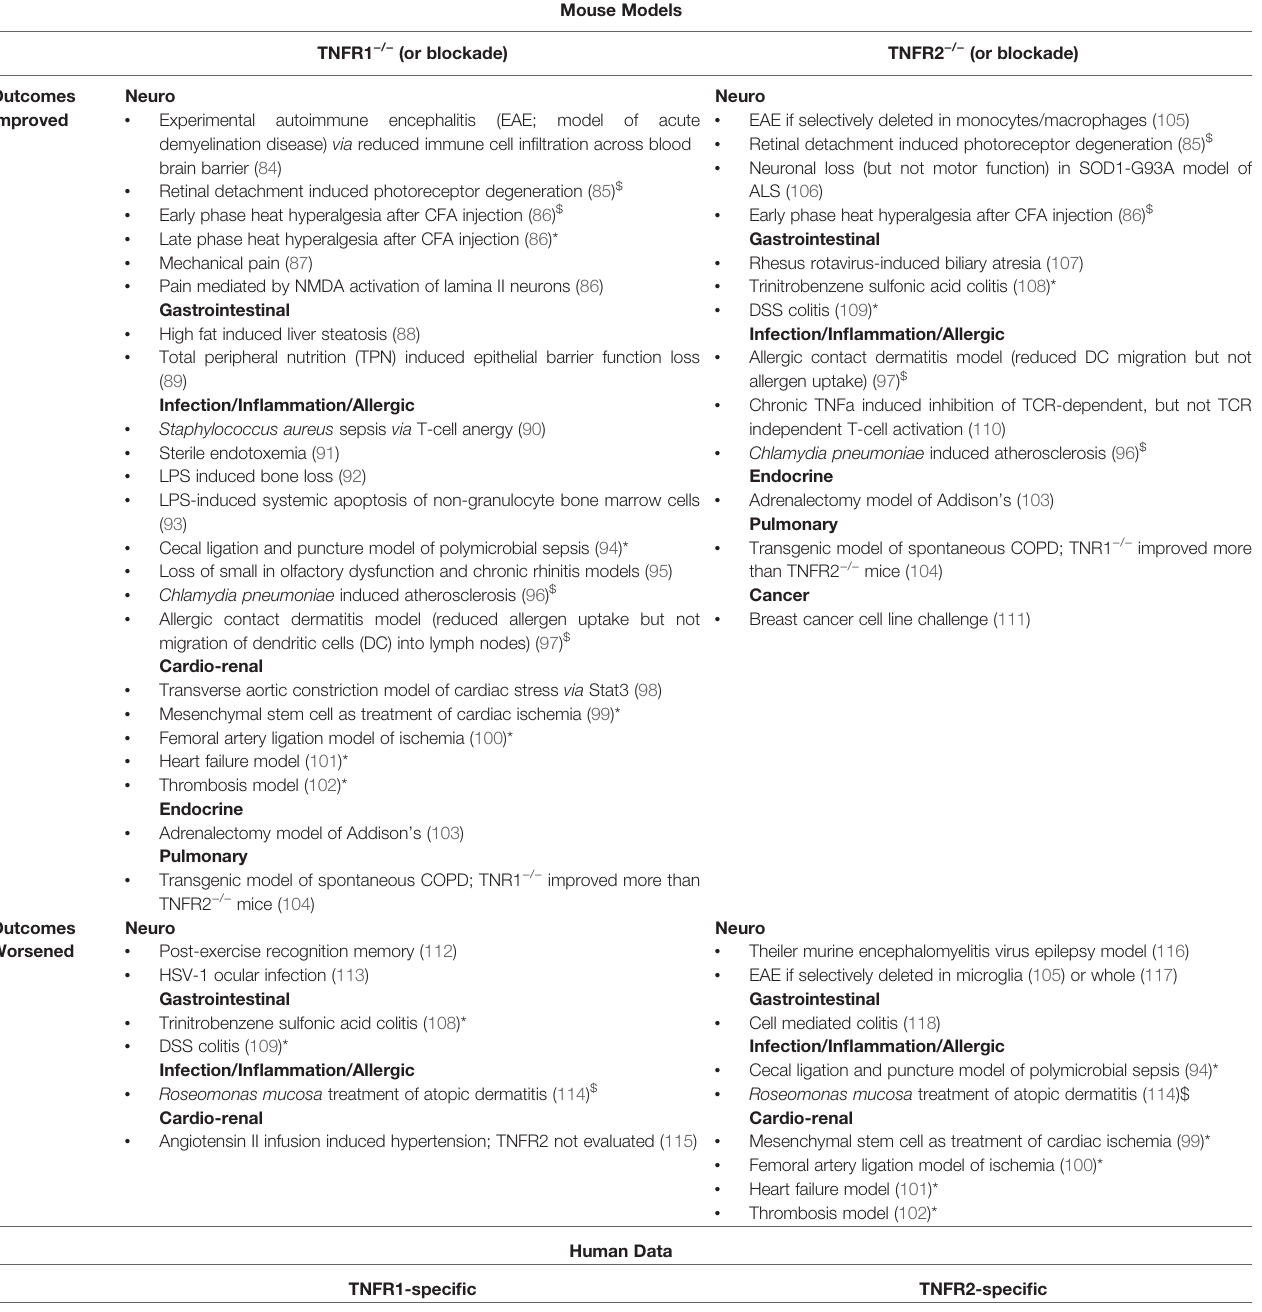
TABLE 1 | Summary of mouse model and clinical association data for TNFR1 versus TNFR2. Mouse Models TNFR1 − / − (or blockade) TNFR2 − / − (or